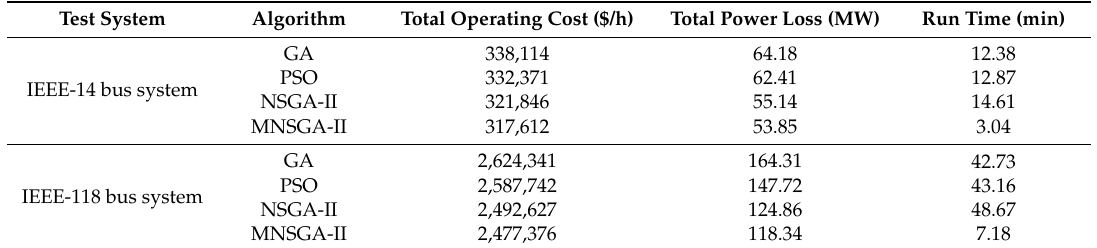
Table 7. Comparison result among GA, PSO, NSGA-II and MNSGA-II for Case